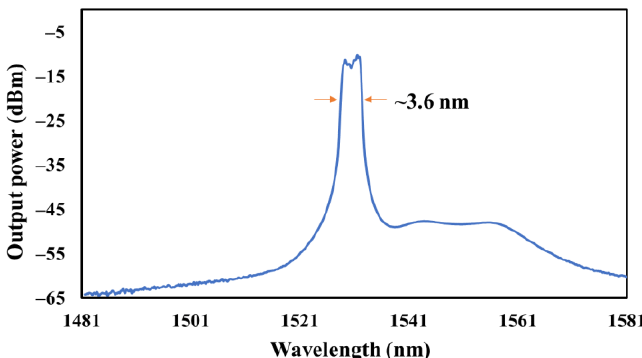
Figure 6. Output spectrum of dissipative soliton mode-locked MAX at 175.87 mW with 3.6 nm spectral edge-to-edge bandwidth.